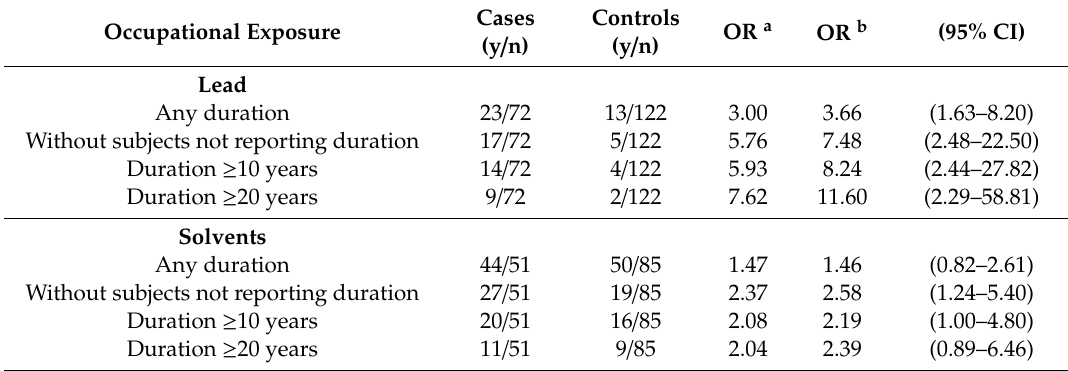
Table 1. Odds ratio (OR) with 95% confidence interval (CI) of amyotrophic lateral sclerosis (ALS) risk according to occupational exposure to lead and solvents and exposure